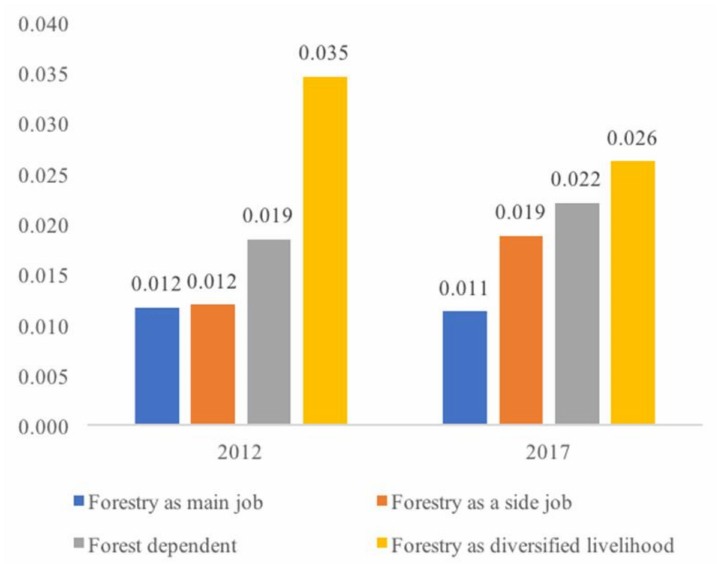
Figure 3. Theil index of livelihood